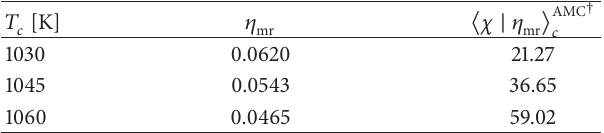
, and the CSDR mr mr